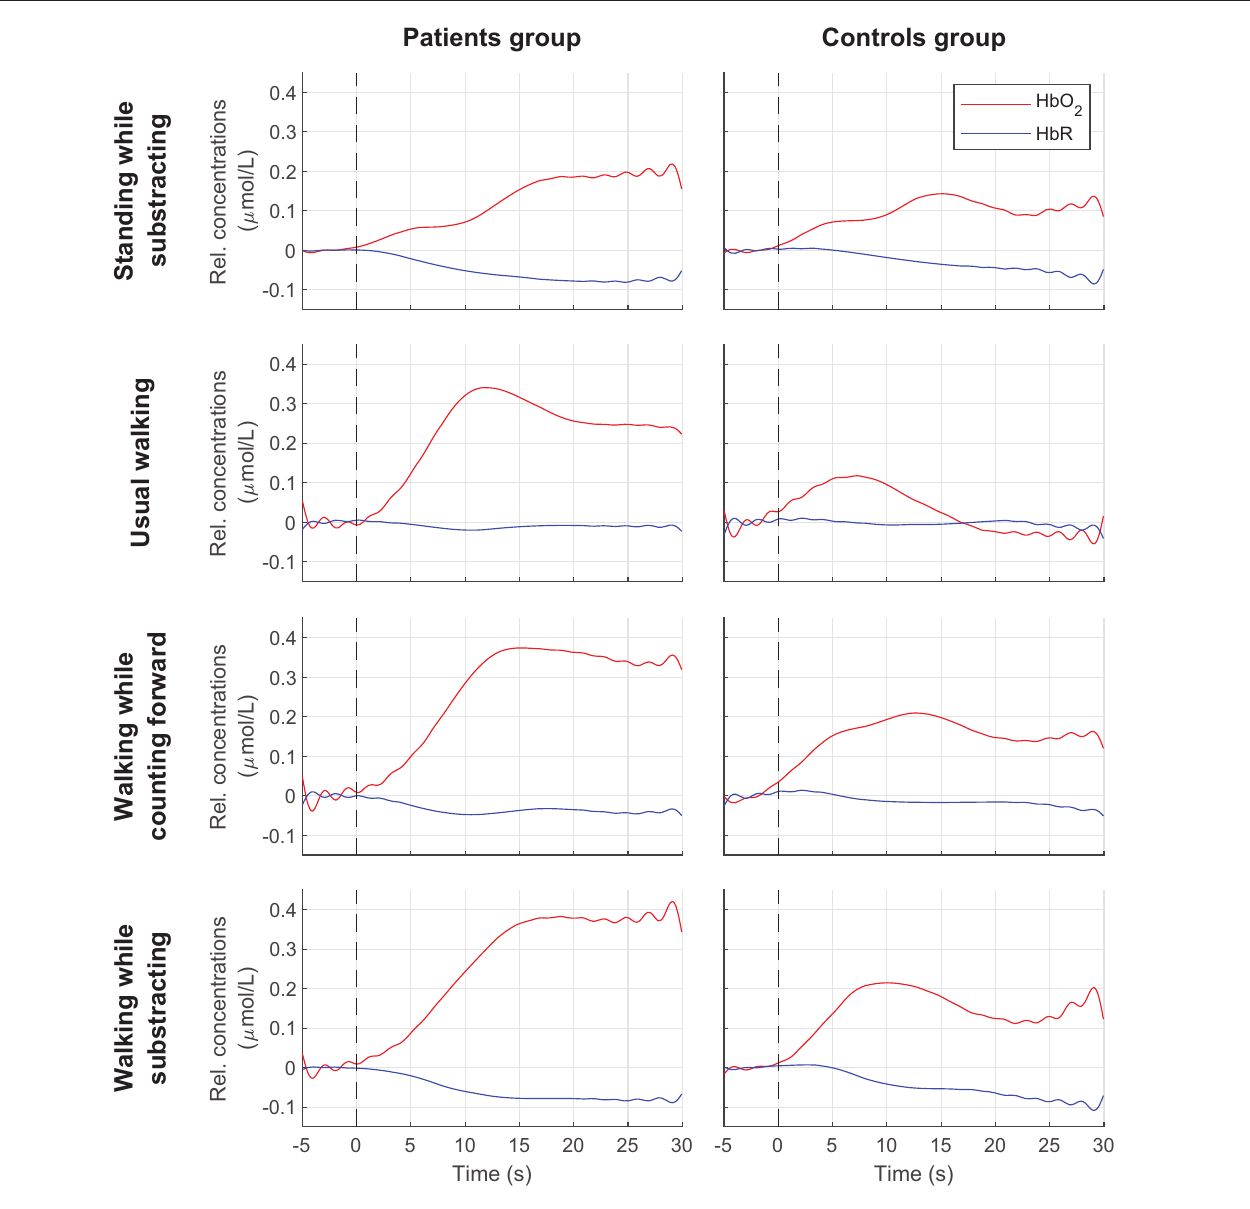
FIGURE 3 | Averaged time courses of HbO 2 and HbR in the DLPFC for each condition in both groups. Vertical dashed lines indicate start of the task. Rel. concentrations, Relative concentrations.